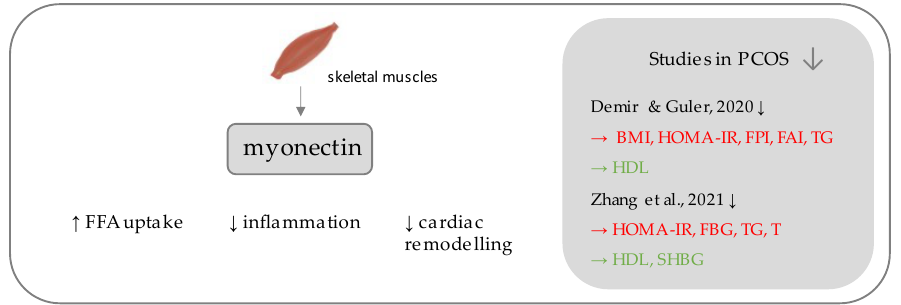
Figure 3. Role of myonectin in the pathogenesis of insulin resistance and PCOS. List of the studies assessing serum nesfatin level in the PCOS patients. ↓ indicates that concentration level of serum myonectin was decreased in PCOS individuals ( p < 0.05); → (green)—indicates positive correlation between serum myonectin and particular indicators; → (red)—indicates negative correlation between serum myonectin and particular indicator; BMI—Body Mass Index; HOMA-IR—Homeostatic Model Assessment for Insulin Resistance; FPI—fasting plasma insulin; FAI—free androgen index; TG— triglycerides; HDL—high density lipoproteins; FBG—fasting blood glucose; T—testosterone; SHBG— sex hormone binding